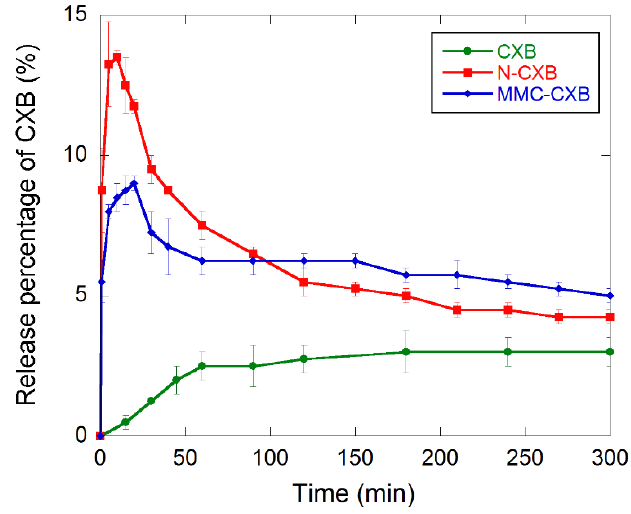
Figure 5. Dissolution profiles for celecoxib in phosphate buffer pH 6.8. Data are presented as mean concentration with error bars representing standard deviations ( n = 3).